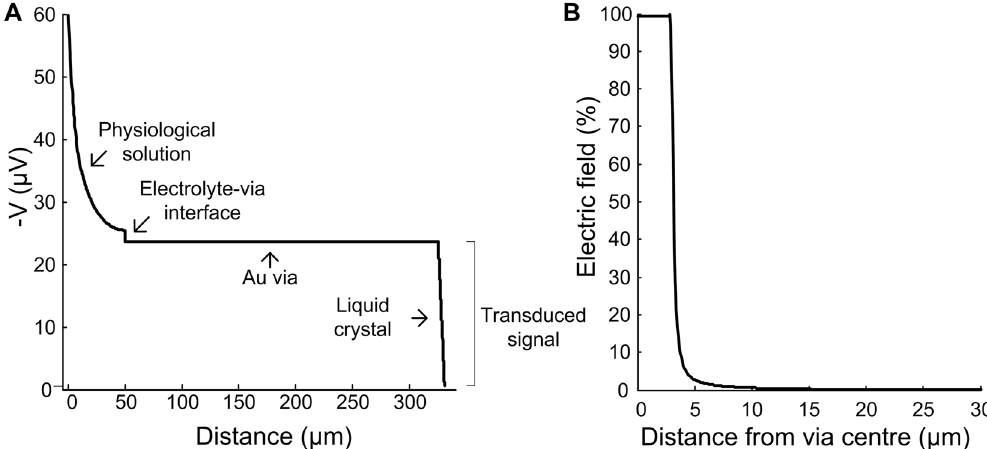
Figure 10. Assessing signal attenuation and channel leakage using a one channel simulation of the optrode device. ( A ) Signal attenuation from the source (neuron) through the various layers of physiological solution and optrode device. Note that the majority of the potential drop occurs in the physiological solution rather than across the optrode’s layers. ( B ) Electric field ( E z ) measured at middle of the LC layer along a line originating at a point directly underlying the centre of a